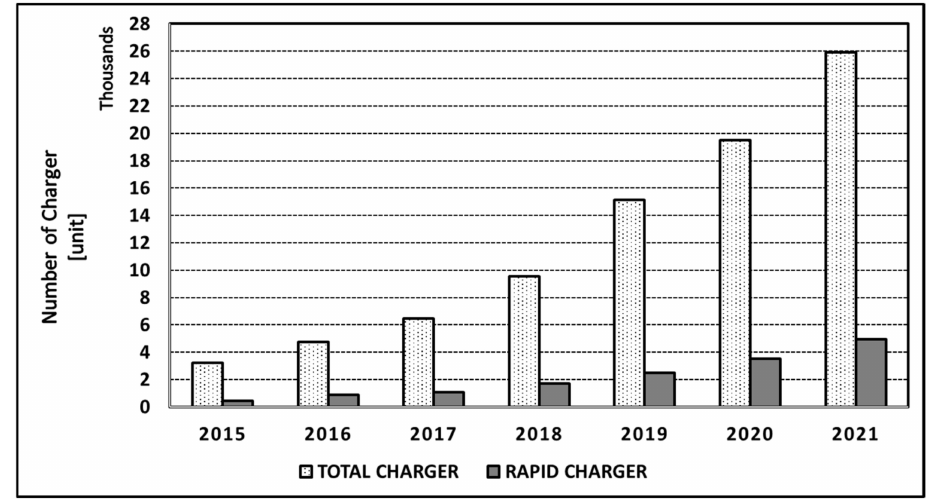
Figure 9. The number of public EV chargers in the UK.